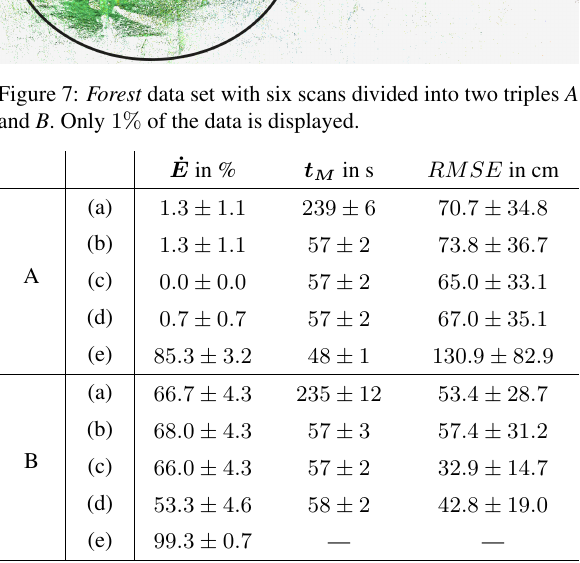
— — Table 5: Failure rate ˙ E , matching time t M , and accuracy of the coarse alignment (RMSE) with the Forest data